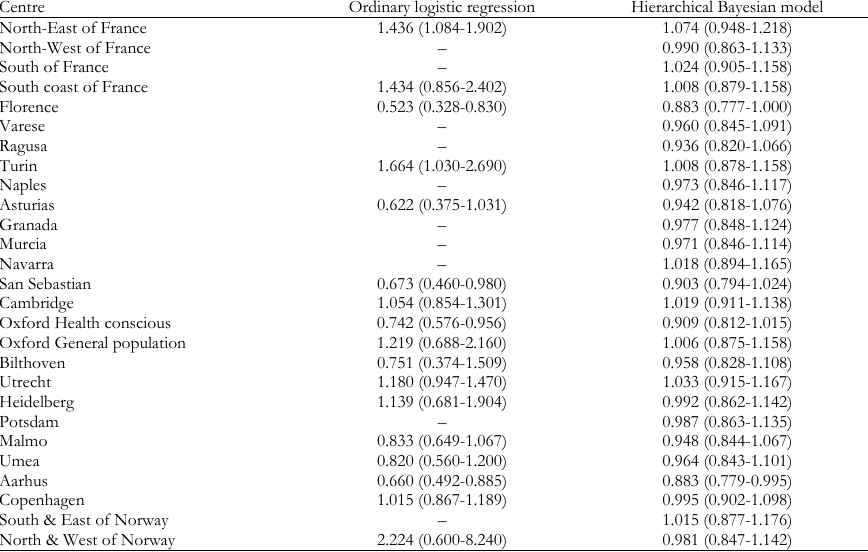
Estimated ORs (95% CI) by centre: